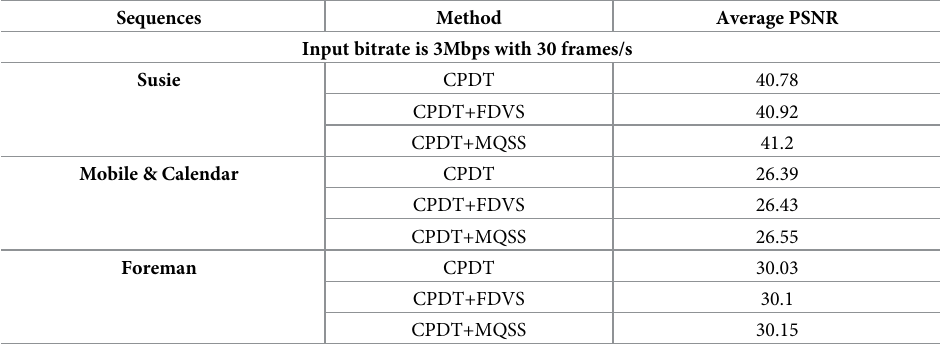
Table 3. Average PSNR comparison using MPEG-2 as a front encoder, for the Susie , Mobile & Calendar and Fore- man sequences which are encoded at QP = 7, and then transcoded at QP = 15.